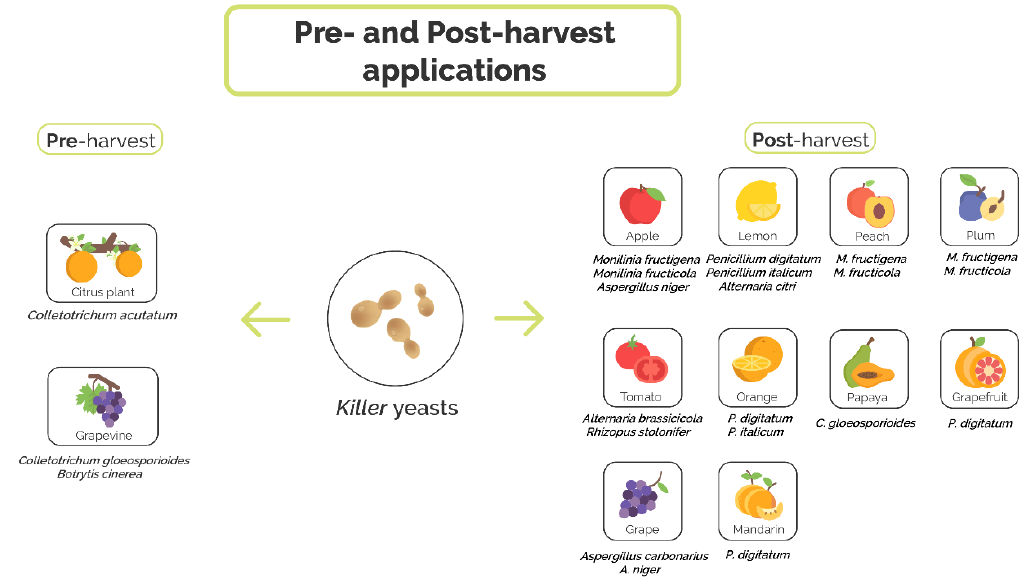
Figure 1. Applications of killer yeasts in agriculture to prevent fungal infections. Killer yeasts have been used for both pre- and postharvest treatments.